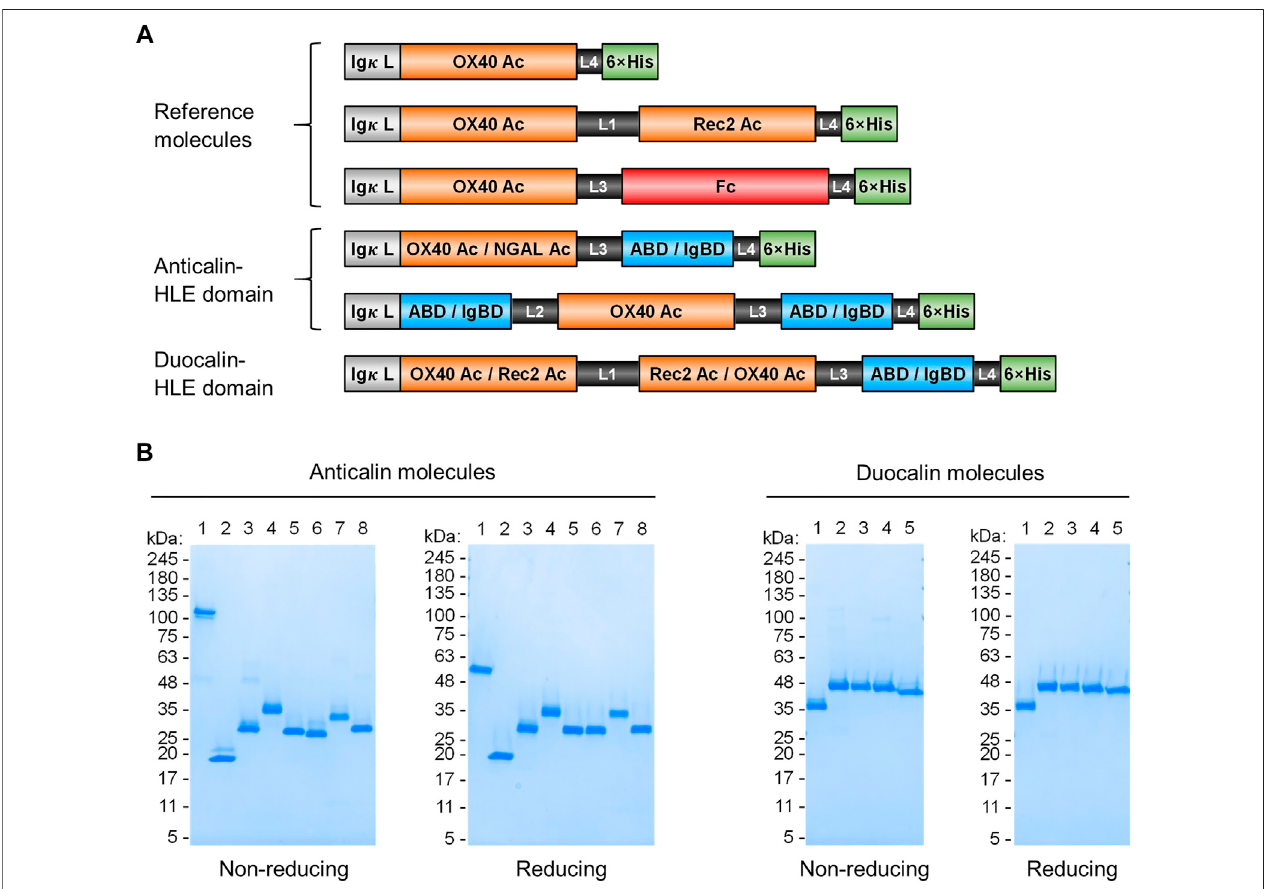
FIGURE 1 | Anticalin proteins fused to serum half-life extension modules. (A) Schematic view of the Anticalin fusion proteins generated in this study. An Anticalin proteinagainstOX40(OX40Ac),thecontrolNGALscaffold(NGALAc)oranAnticalinproteinagainstanotherTNFRSFmember(Rec2Ac)werefusedwithABD,IgBDorFcin differentAnticalin and Duocalinarrangements.Ig κ L,immunoglobulin κ leaderpeptide;L1, (GGGGS) 3 ; L2, GGSGGGGTGG; L3,(GGSGG) 2 ; L4, AAAGGS. (B) Two µgeach of Anticalin proteins (left) and Duocalin proteins (right) were analyzed by non-reducing and reducing SDS-PAGE and subsequent Coomassie staining. Anticalin proteins: (1) OX40 Ac-Fc, (2) OX40 Ac, (3) OX40 Ac-ABD, (4) ABD-OX40 Ac-ABD, (5) NGAL Ac-ABD, (6) OX40 Ac-IgBD, (7) IgBD-OX40 Ac-IgBD, (8) NGAL Ac-IgBD. Duocalin proteins: (1) OX40 Ac-Rec2 Ac, (2) OX40 Ac-Rec2 Ac-ABD, (3) OX40 Ac-Rec2 Ac-IgBD, (4) Rec2 Ac-OX40 Ac-ABD, (5) Rec2 Ac-OX40 Ac-IgBD.